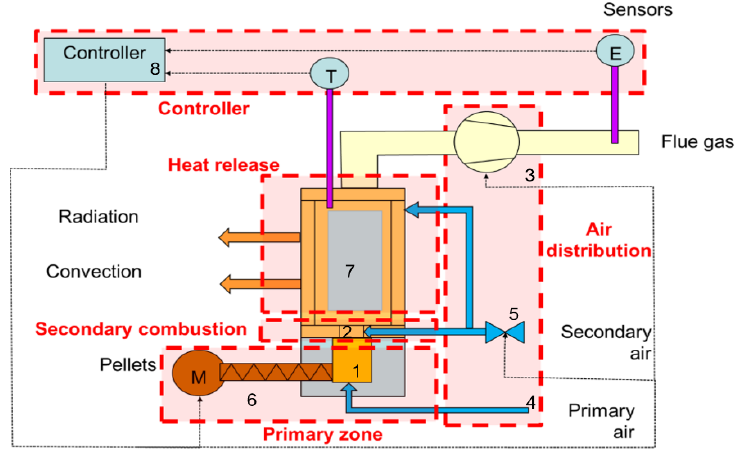
Figure 1. Typical construction of a two-stage combustion stove.